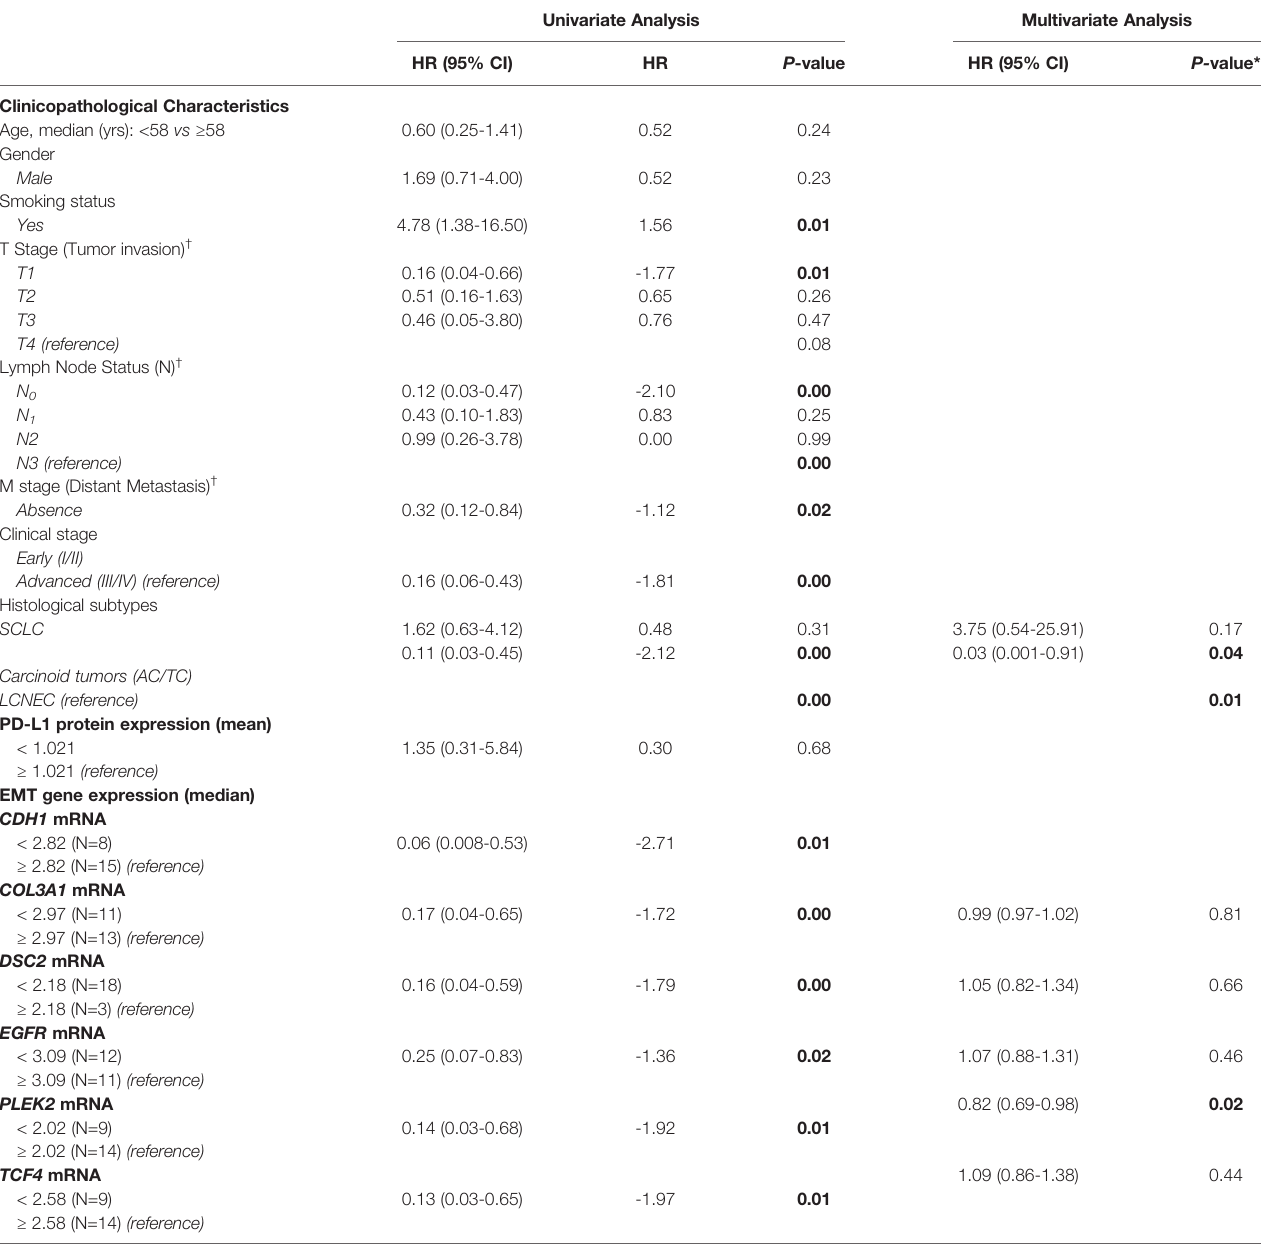
TABLE 4 | Variables associated with overall survival (OS) in PNENs patients. Univariate Analysis Multivariate